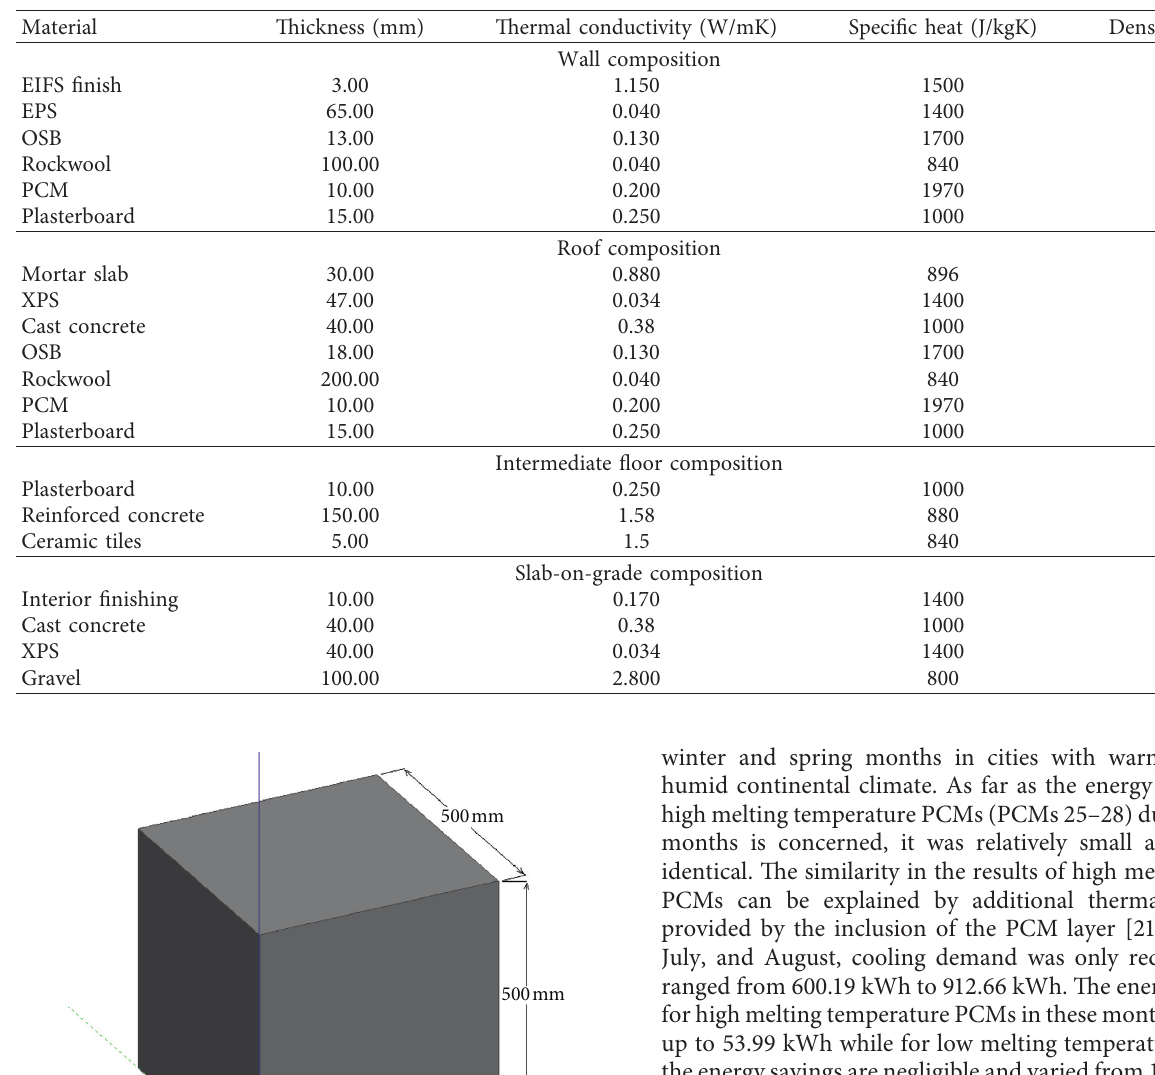
Table 2: Thermophysical properties of building materials [21].